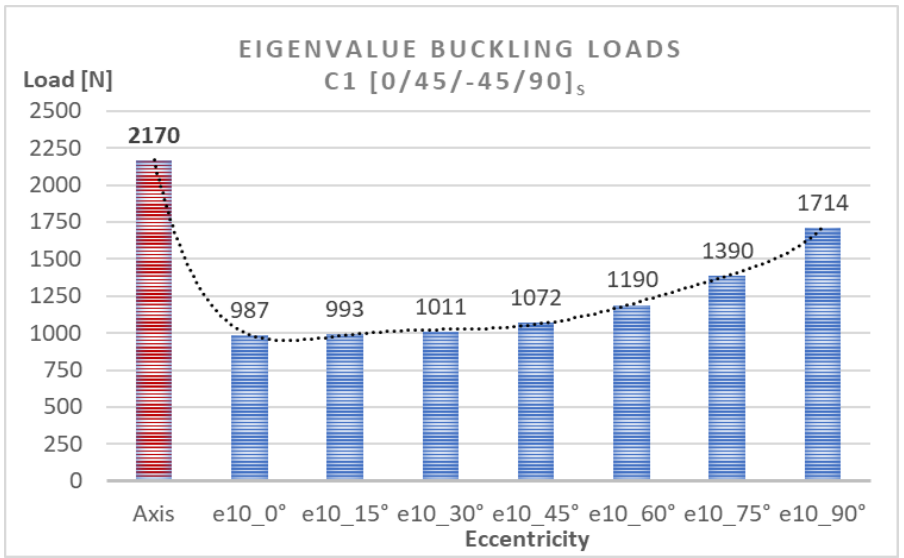
Figure 10. Eigenvalue buckling loads for C1 [0/45/ − 45/90] s .